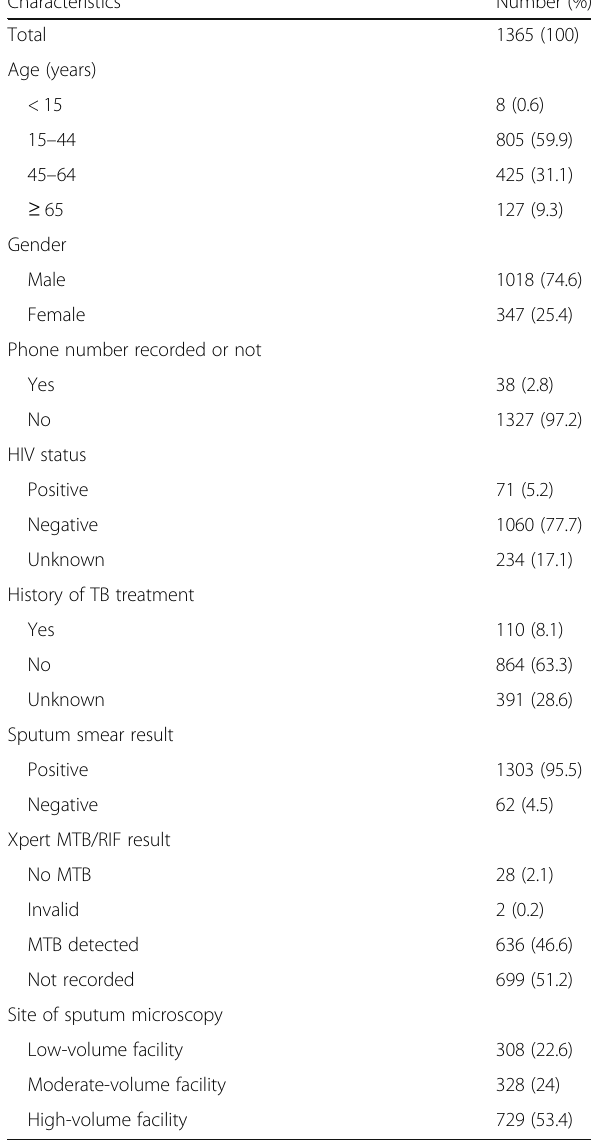
Table 1 Demographic and clinical profile of bacteriologically- confirmed TB patients diagnosed in 21 township health centres of Mandalay Region of Myanmar between January and June 2017